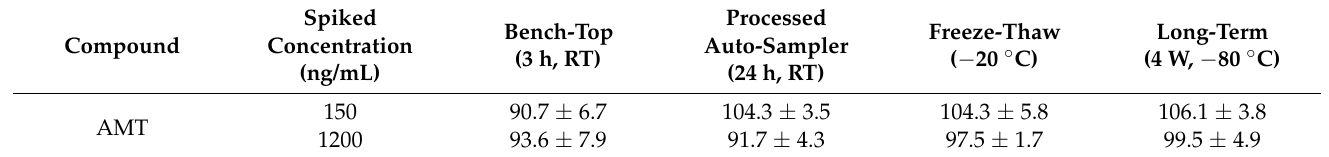
Table 4. Stability of AMT in plasma and processed samples under various storage conditions (n =